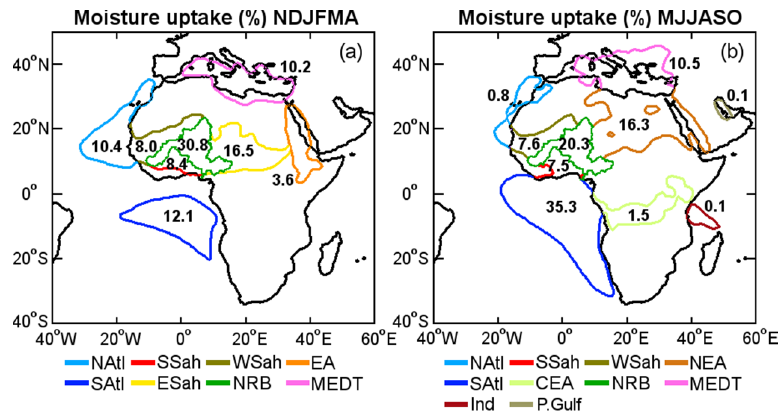
Figure 9. Percentage moisture uptake ( (E – P) > 0) by the NRB over the climatological sources during NDJFMA ( a ) and MJJASO ( b ). The colour contours indicates the boundaries of the moisture sources in both seasons.